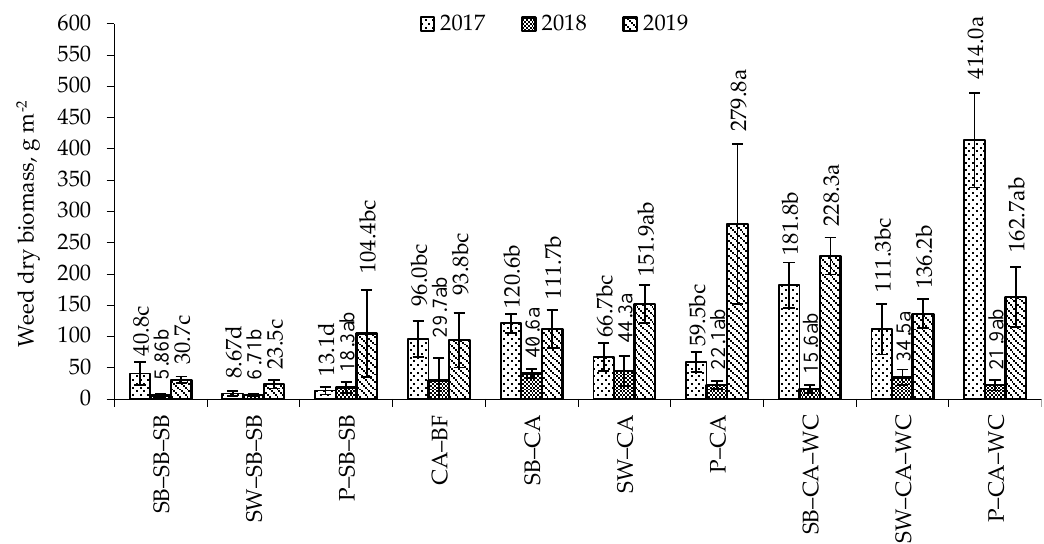
Figure 5. Weed dry biomass in sole, binary, and trinary crops in 2017–2019. Note. CA—caraway, SB—spring barley, SW— spring wheat, P—pea, WC—white clover, BF—black fallow. Differences between the averages of treatments marked with different letters (a, b, c) are significant ( p < 0.05); error bars indicate the standard error.